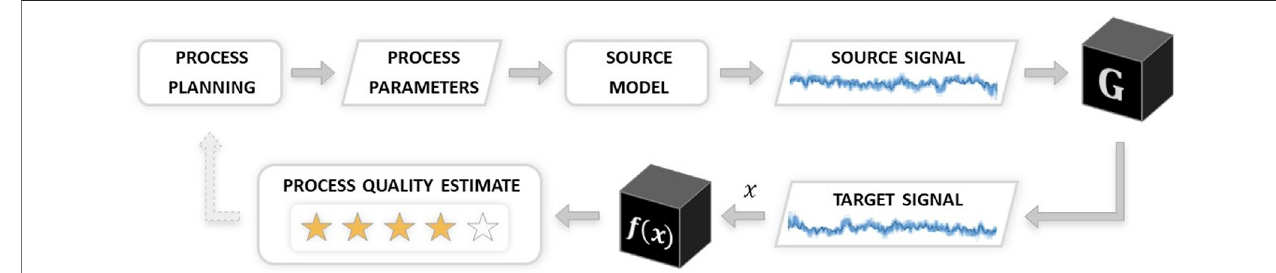
FIGURE 7 | Proposed generator model as a part of a process optimisation fl